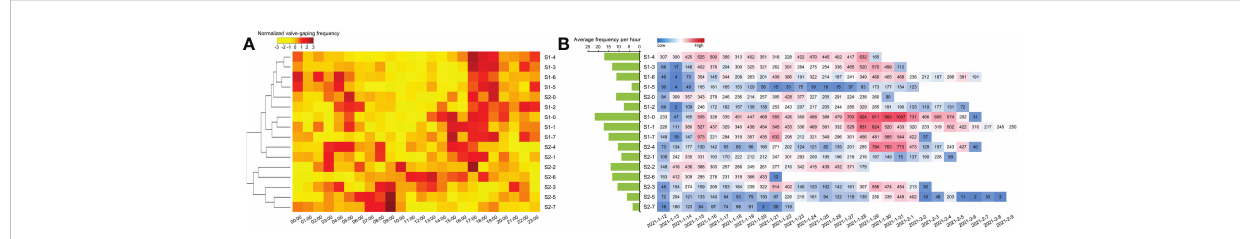
FIGURE 3 Frequency of valve movements in monitored scallops. (A) Heatmap showing the circadian rhythm of valve movements among the scallops based on the hourly average frequencies of 24-h time points. (B) In order of sample ID, the histogram shows the average activity frequency per hour throughout the experiment for each scallop. In addition, the number of daily valve movements for each scallop is highlighted with colors varying from blue to red, representing the scale of the daily frequency